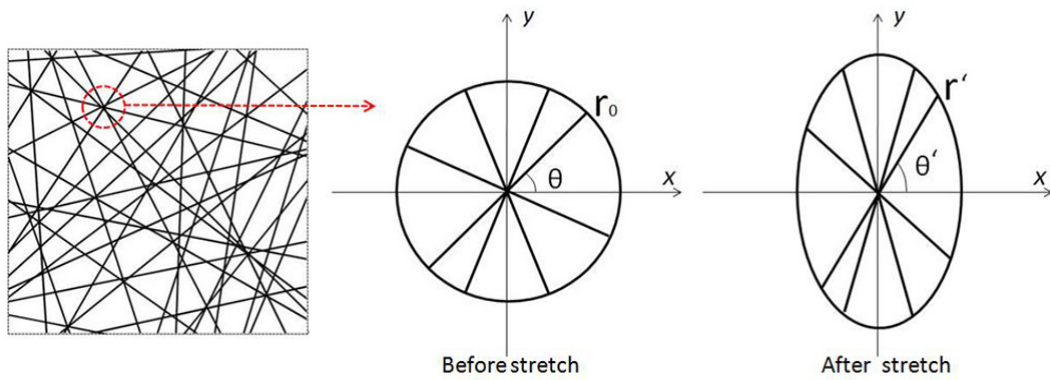
Figure 2. Changing of fiber’s orientation under stretch.